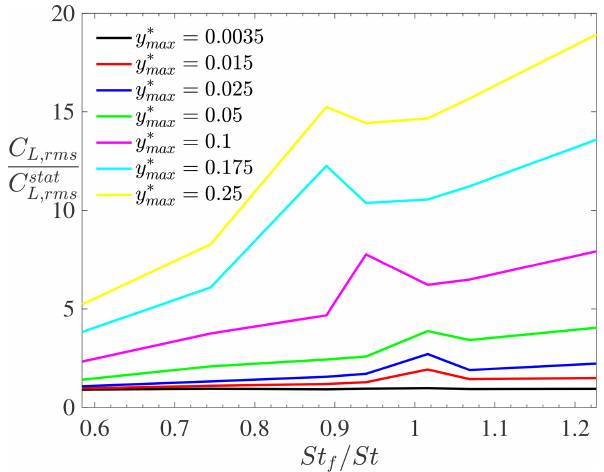
Figure 9. Root mean square of the lift coefficient (non- Figure 8. Root mean square of the lift coefficient (non- dimensionalized by its value for a stationary cylinder) for forced dimensionalized by its value for a stationary cylinder) for forced vibrations compared with NASA experimental data (Jones et al., vibrations in the supercritical turbulent regime with different fre- 1969) at three values of the prescribed motion amplitude. quency ratios St f / St and prescribed motion amplitudes y ∗ max . Table 3. Range of frequency ratios and velocities considered for the forced vibration of a cylinder in the supercritical regime. St f / St U ∗